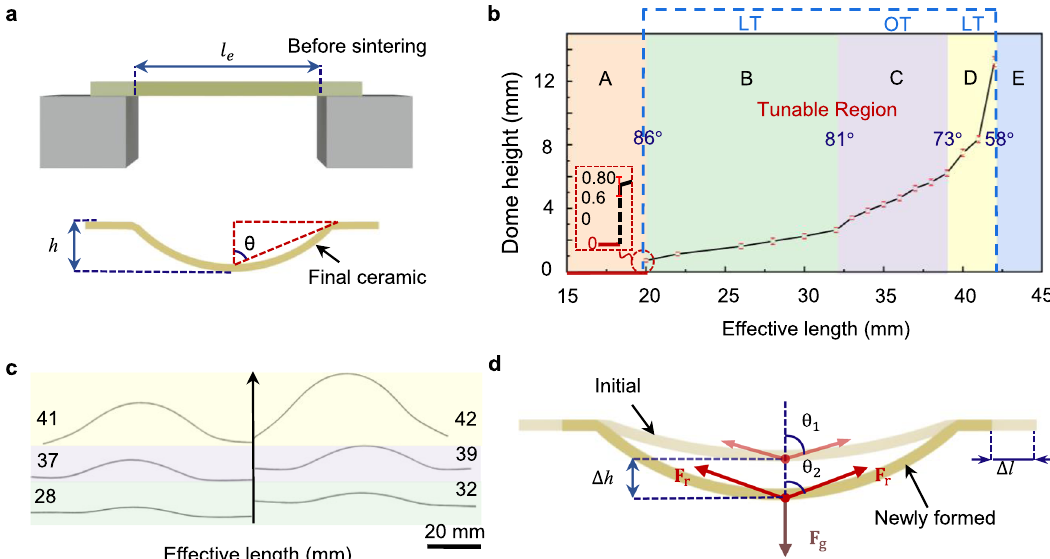
Fig. 3 Reliability and tunability study of the GDS method. a Schematic illustration of the two key variables: dome height h and effective length l e . b The relation of dome height h with respect to effective length l e . The blue dashed box highlights the tunable region which is de fi ned into two segments, namely, the low tunability (LT) region and optimal tunability (OT) region. The narrow error bars demonstrate that the GDS process is reliable. c Scanning pro fi les of the surfaces of six specimens in regions B, C, and D, respectively. The numbers marked on the pro fi les denote the values of l e . d Schematic of the simpli fi ed model, where the effect of viscosity behavior of the quasi-liquid specimen is simpli fi ed as two equivalent resistance forces: F r that balances the gravitational force F g